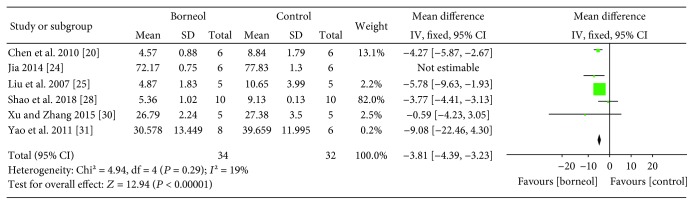
The forest plots: the borneol group versus the control group on brain Evans blue content under pathological conditions.